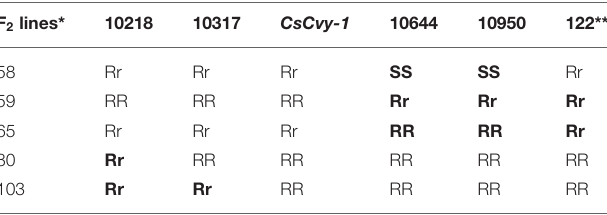
TABLE 1 | Molecular markers used to define the interval for CsCvy- 1 locus and the critical recombinant F 2 lines. F 2